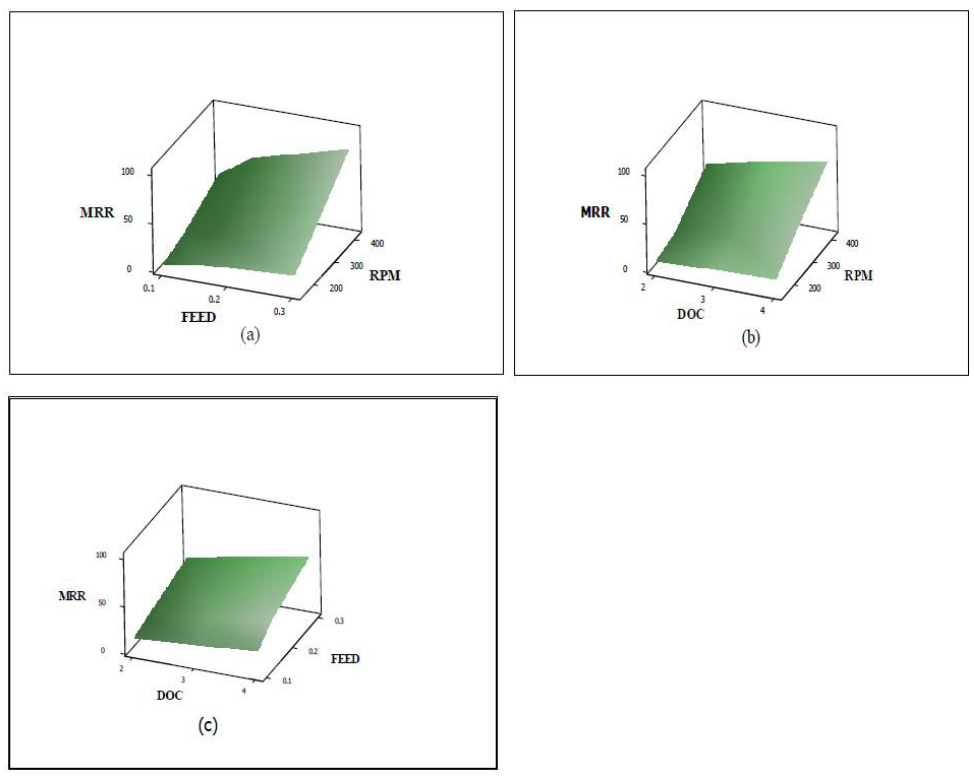
Figure 6. Surface plot of MRR ( a ) MRR Vs. f , N ( b ) MRR Vs. d , N ( c ) MRR Vs. d , f .